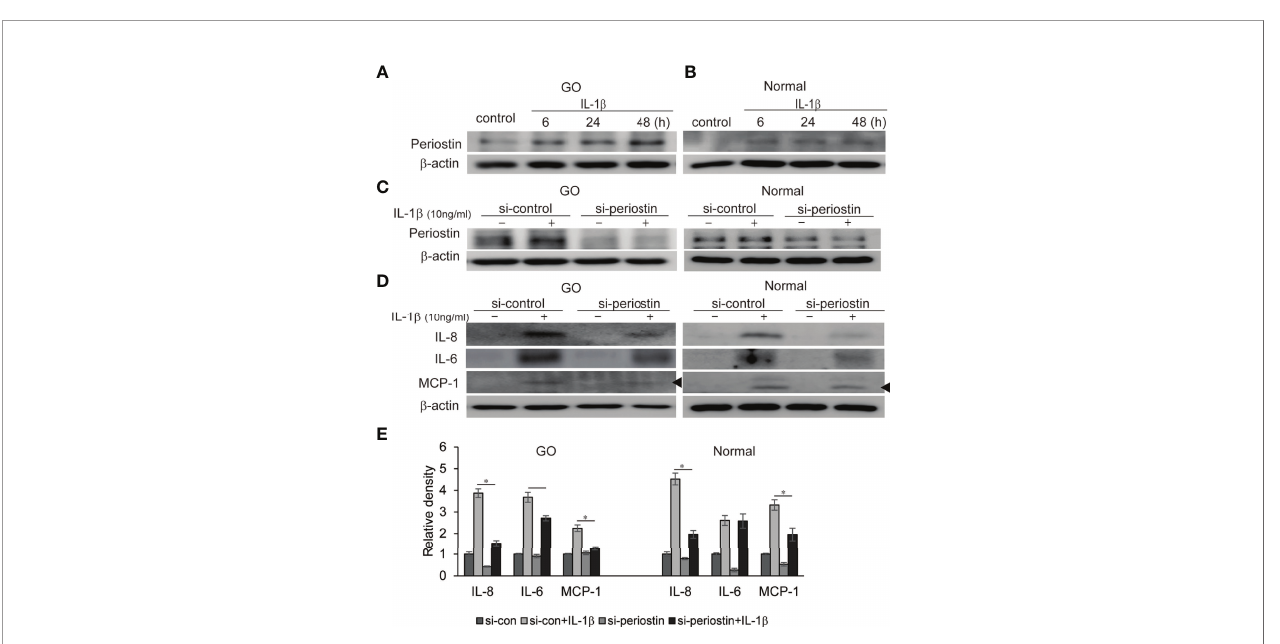
FIGURE 5 | Effect of silencing periostin on production of IL-1 b -induced proin fl ammatory proteins in GO and normal fi broblast. Orbital fi broblasts from GO patients (n=3) (A) and normal patients (n=3) (B) were treated with 10 ng/ml IL-1 b for 6-48 hours. IL-1 b increased expression of periostin protein in a time-dependent manner in GO cells, more predominantly. (C, D) Knockdown of periostin by siRNA transfection ameliorated IL-1 b -induced production of proin fl ammatory protein in Western blot analyses. IL-1 b induced IL-6, IL-8 and MCP-1 protein production was suppressed by silencing periostin in both GO and normal orbital fi broblasts. Representative bands from western blot analyses were shown (A – D) . (E) The results from orbital fi broblasts are presented as the mean density ratio ± SD, normalized to the level of b -actin in the same sample. ( *p < 0.05 vs. IL-1 b -stimulated